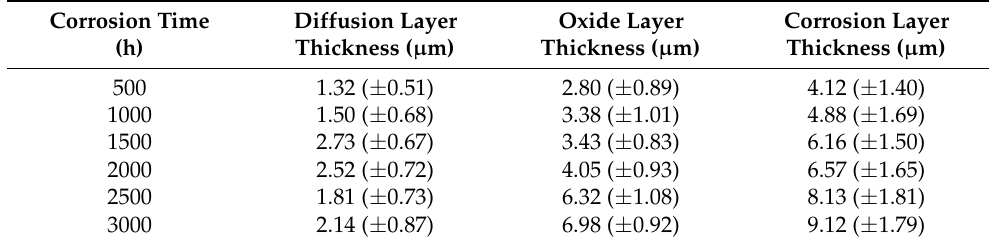
Table 1. The statistical thicknesses of the diffusion layer, oxide layer and corrosion layer of LBE- corroded Ti 3 SiC 2 samples.